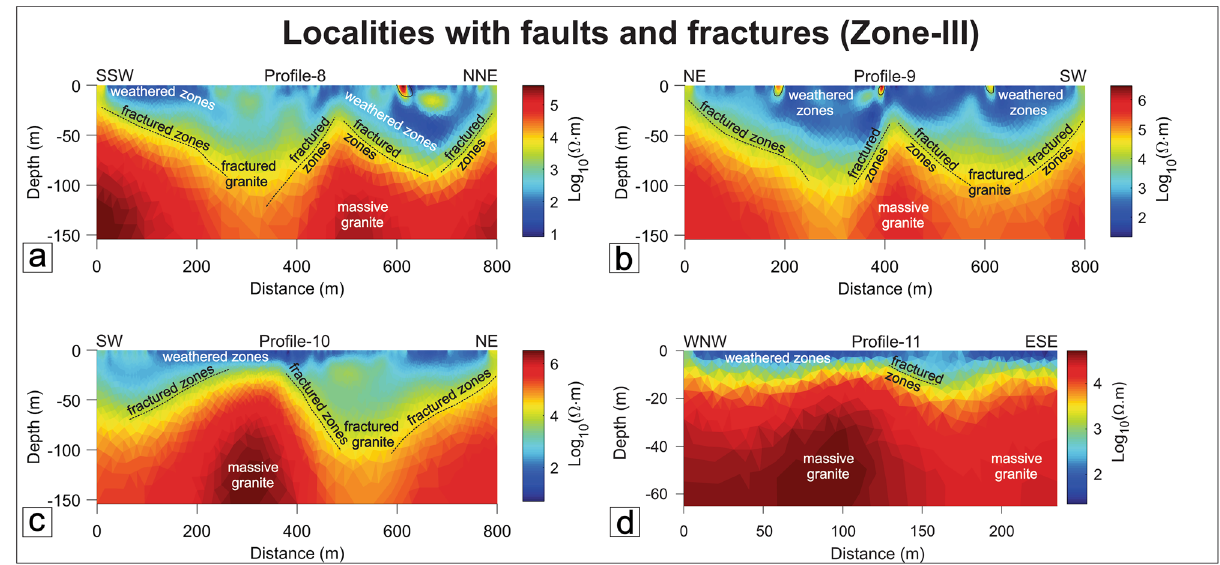
Figure 15. Resistivity profiles in Zone-III. ( a ) Profile-8, Padni area, ( b ) Profile-9, Nichli Ghoda area, ( c ) Profile-10, Kanpura area, ( d ) Profile-11, Ganji area.